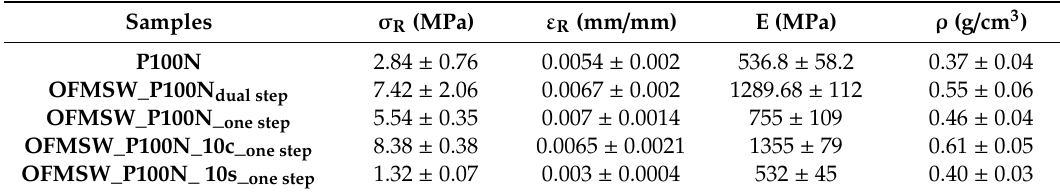
Table 4. Mechanical properties and density of dual step and one step process cured